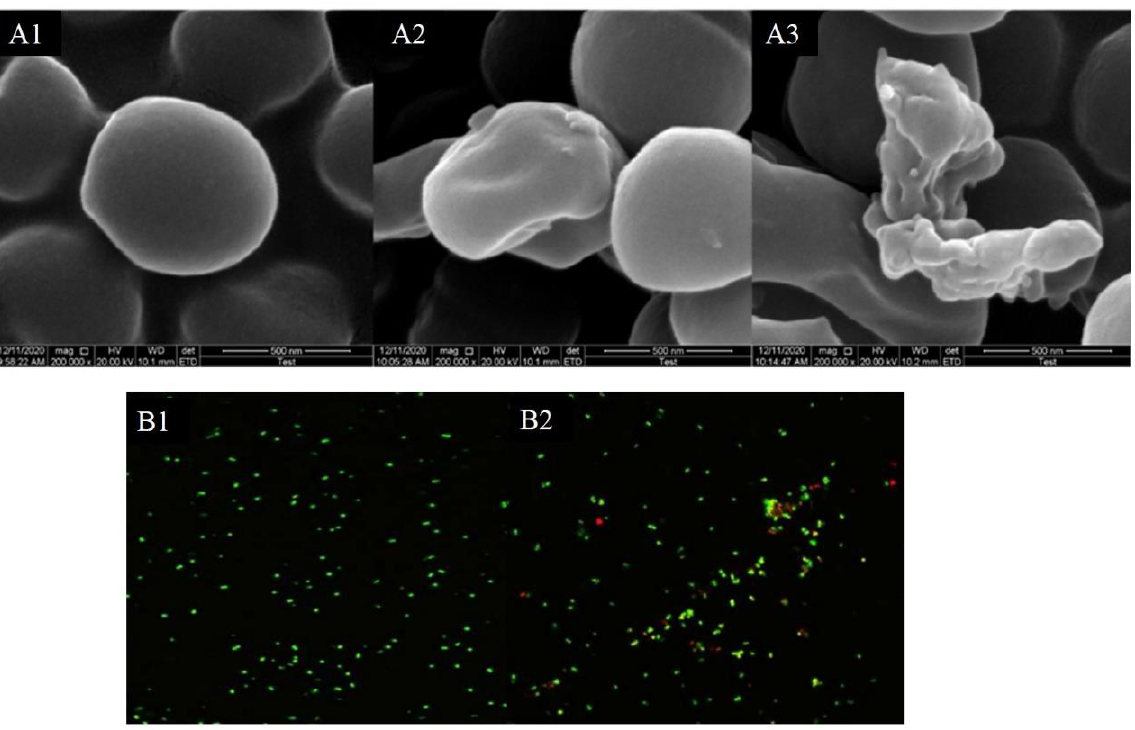
Figure 3. Observation of morphology changes in S. aureus by SEM ( A ) and CLSM ( B ). Note: ( A1 ) S. aureus only (control group); ( A2 ) S. aureus treated with 25 mg/mL skin mucus extract; ( A3 ) S. aureus treated with 50 mg/mL skin mucus extract; ( B1 ) S. aureus only (control group); ( B2 ) S. aureus treated with 25 mg/mL skin mucus.